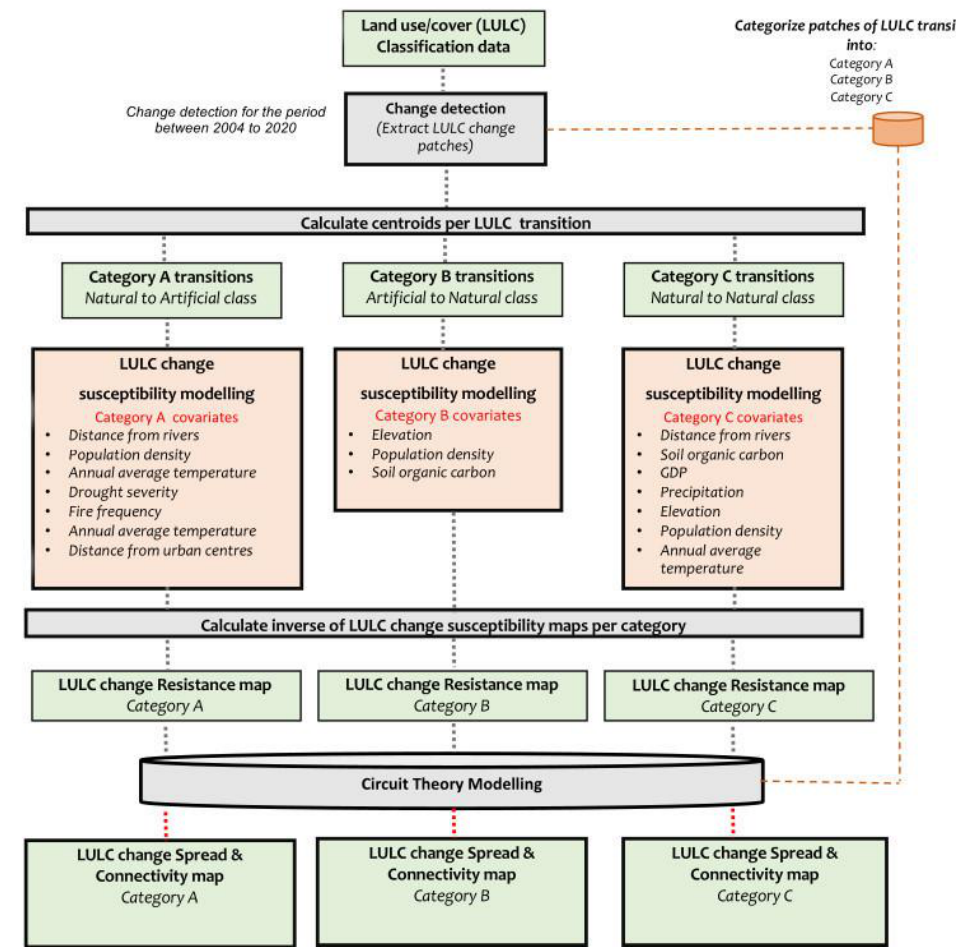
Figure 2. Study methodology workflow. The LULC classification data are derived from results by Kavhu et al. [46]. Covariates for each category were derived from results by Kavhu et al. [41].